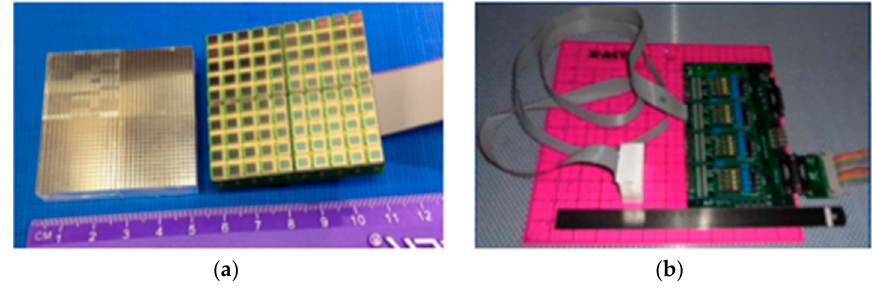
Figure 4. ( a ) Basic components of the original AM-PET Helmet_PET modules. Four 16 × 16 LYSO arrays were pieced together to form a 32 × 32 array. These were coupled to four 5 × 5 MPPC pixel arrays to form a 10 × 10 pixel MPPC array per module. ( b ) Electronic amplifiers were located outside of the module to reduce weight, size, power generation, and minimize magnetic field susceptibility [16].